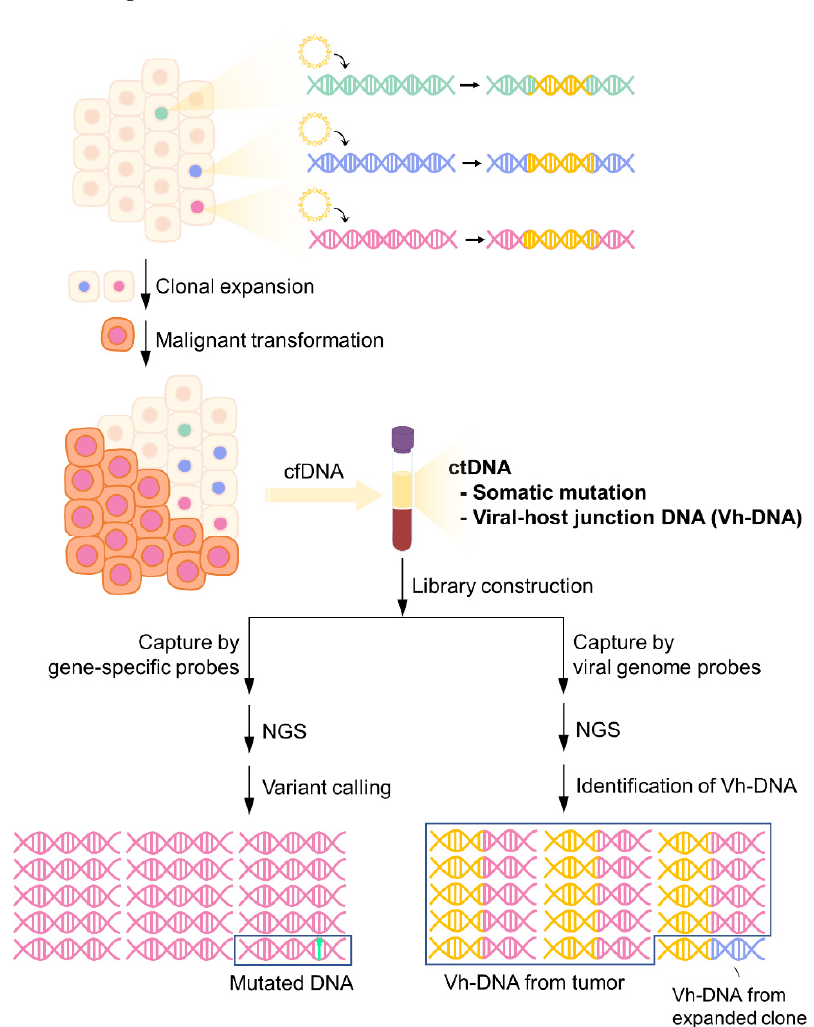
Figure 1. Detection of somatic mutations and vh-DNA from cfDNA by targeted-NGS. Virus DNA integrates into the host genome during infection. Infected cells may undergo clonal expansion due to insertional mutagenesis and eventually become tumor cells through the accumulation of somatic mutations. As cell-free tumor markers, both tumor-specific somatic mutations and vh-DNA can be detected in plasma. However, the frequency of somatic mutations is low in cfDNA, while tumor- released vh-DNA is the main component of the total population of vh-DNA.